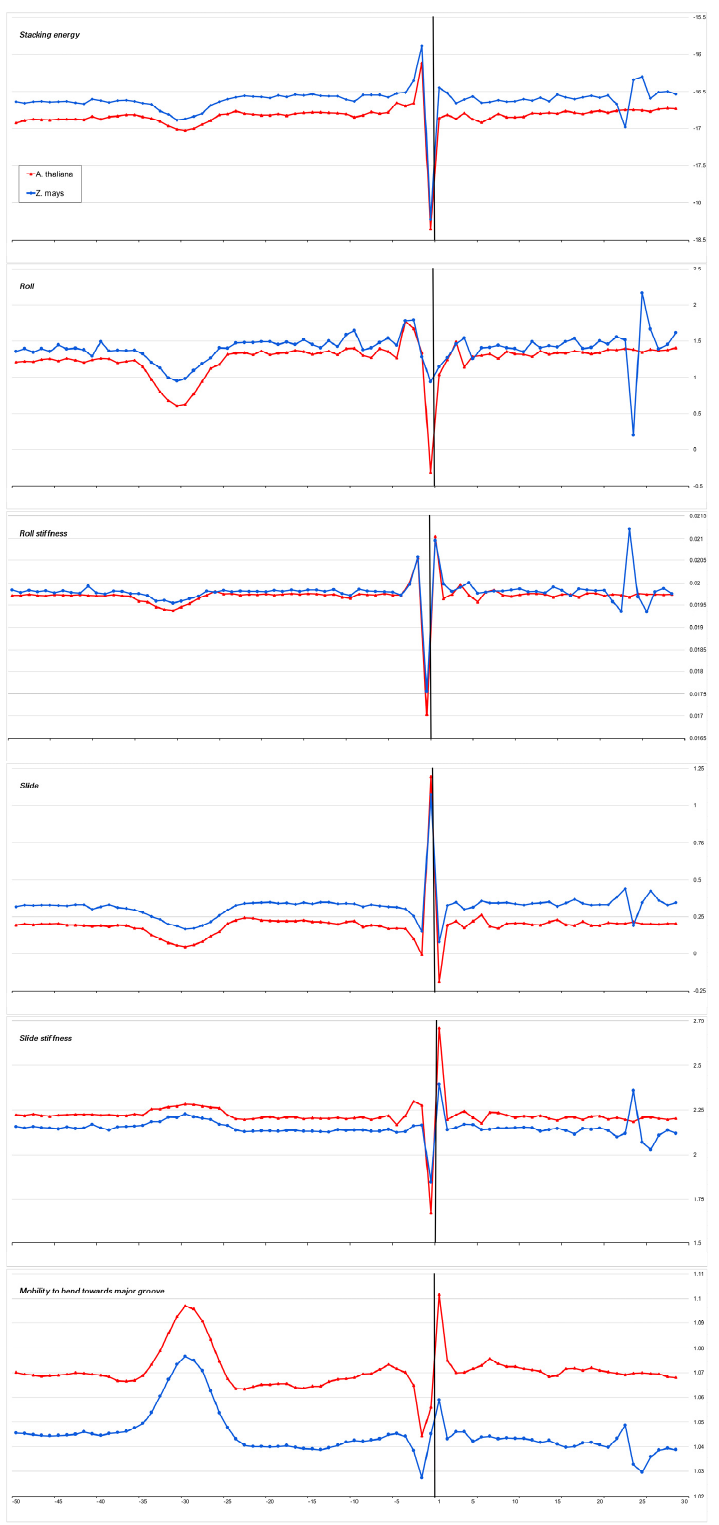
Figure 5. Local variations of the values of physical and structural parameters in core promoter regions of A. thaliana and Z. mays. ( a ) Stacking energy (in kcal/mol). ( b ) Roll (in degrees). ( c ) Stiffness of the duplex structure to Roll alteration (in kcal/mol degree). ( d ) Slide (in angstroms). ( e ) Stiffness of the duplex structure to Slide alteration (in kcal/mol angstrom). ( f ) Mobility to bend towards major groove (in mobility